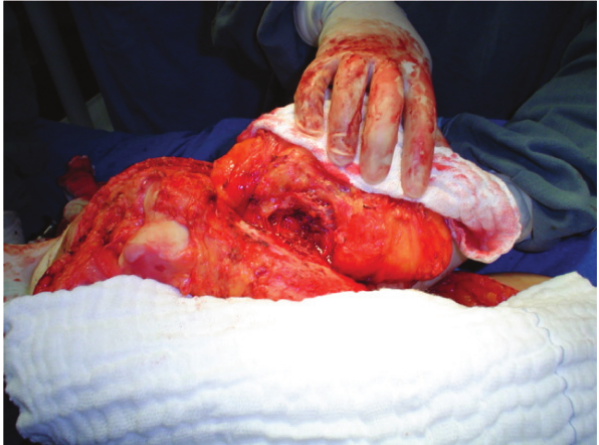
Figure 4 - Intraoperative photograph showing resection of a tumor of large